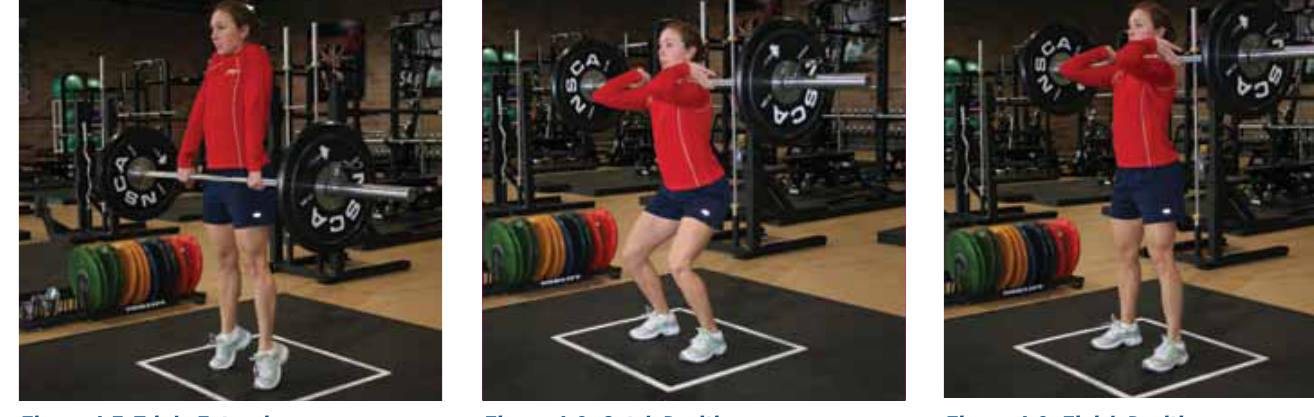
Figure 4-7. Triple Extension Figure 4-8. Catch Position Figure 4-9. Finish